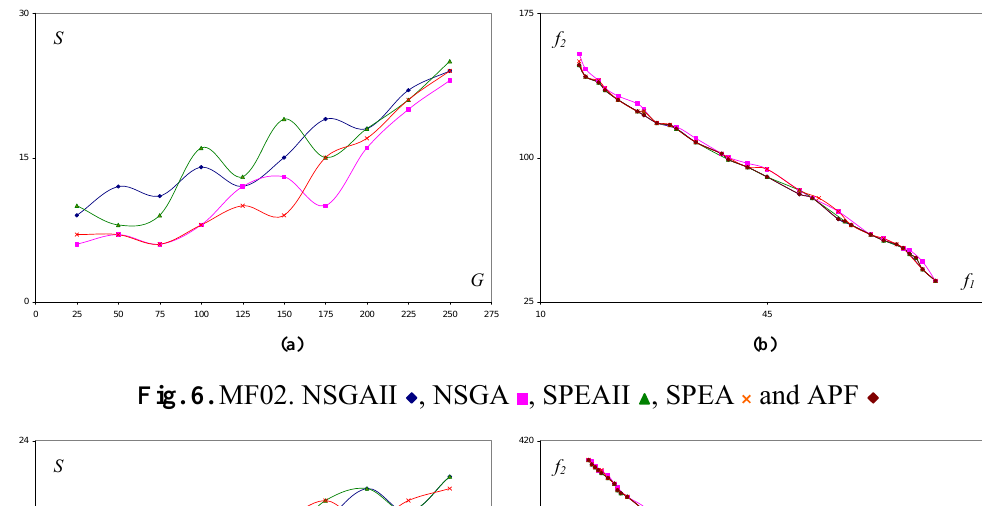
Fig. 5. MF01. NSGAII , NSGA , SPEAII , SPEA and APF